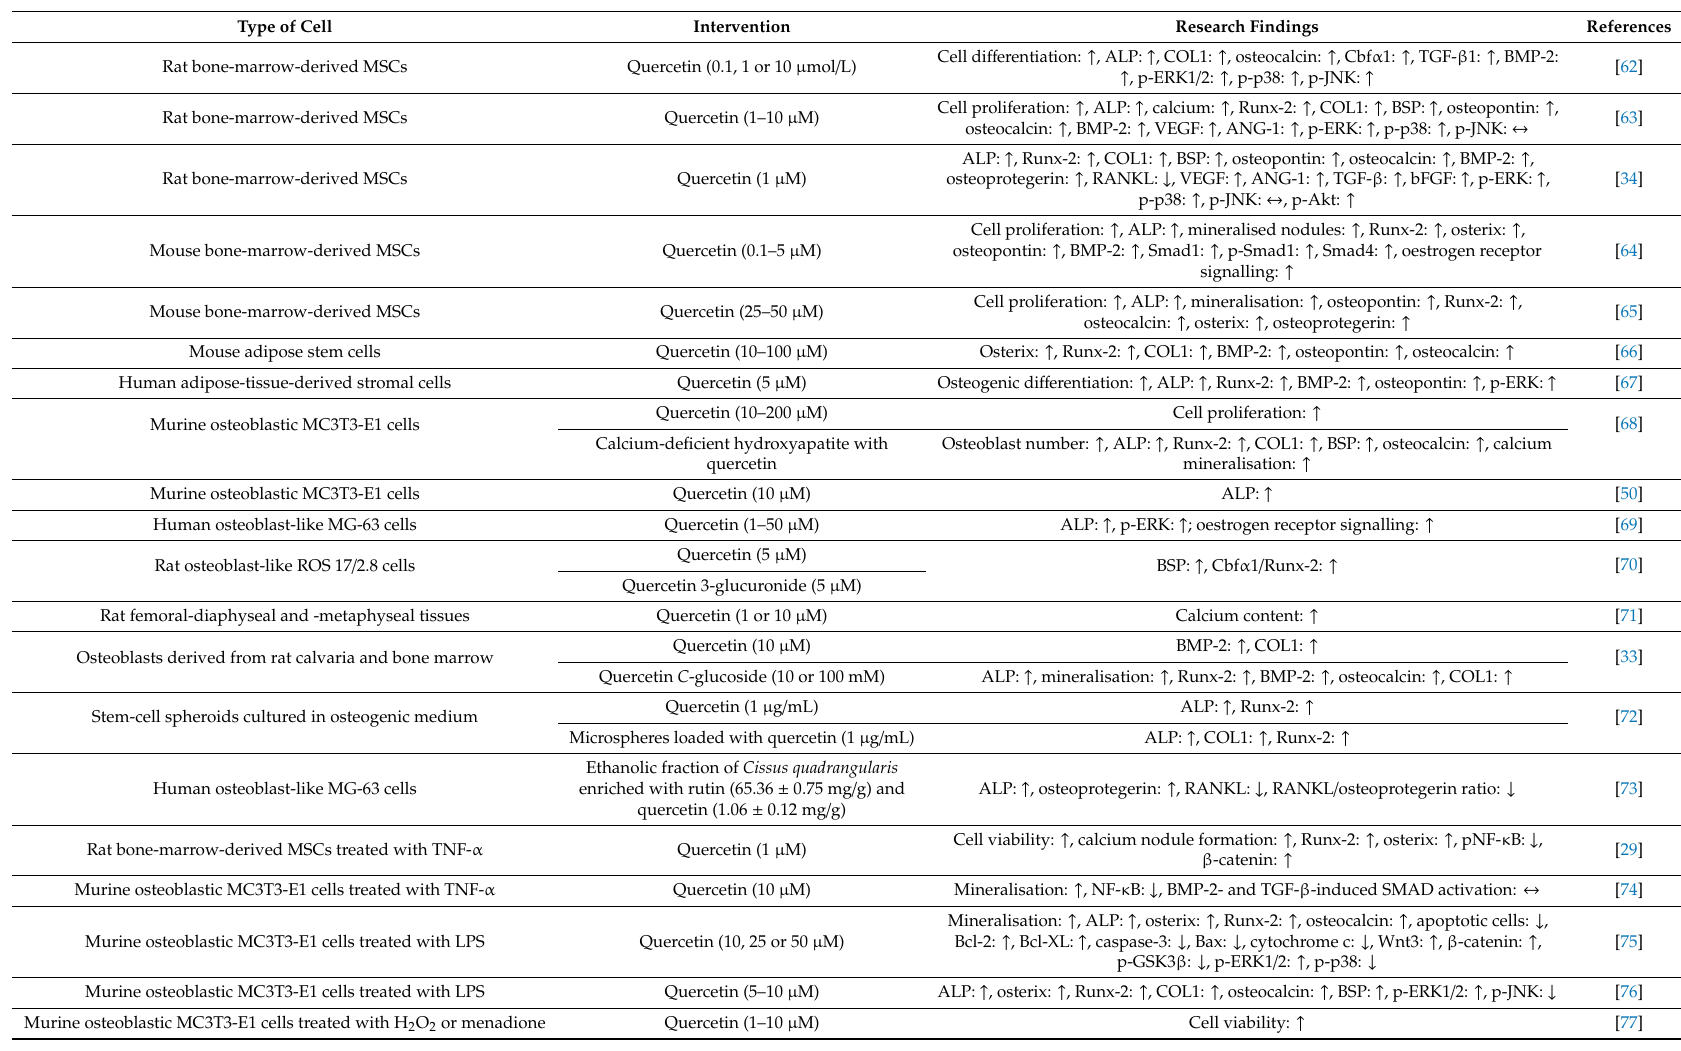
Table 2. The e ff ects of quercetin on bone cells. Symbol ↑ indicates an increase or upregulation, ↓ indicates a decrease or downregulation and ↔ indicates no change. Type of Cell Intervention Research